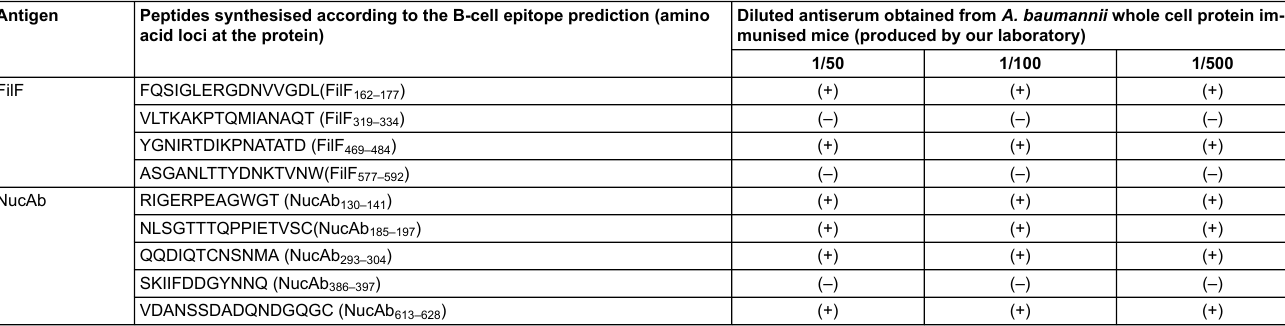
Table 1: Serological detection and analysis of the synthetic peptides from B-cell epitope prediction. Antigen Peptides synthesised according to the B-cell epitope prediction (amino acid loci at the protein)